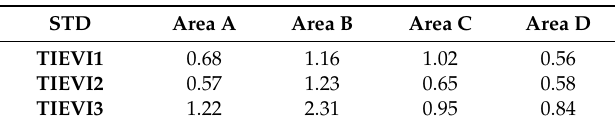
Table 5. The standard deviation of TIEVI 1, TIEVI 2, and TIEVI 3 from the four experiment areas (Area A, B, C, and D) was counted,